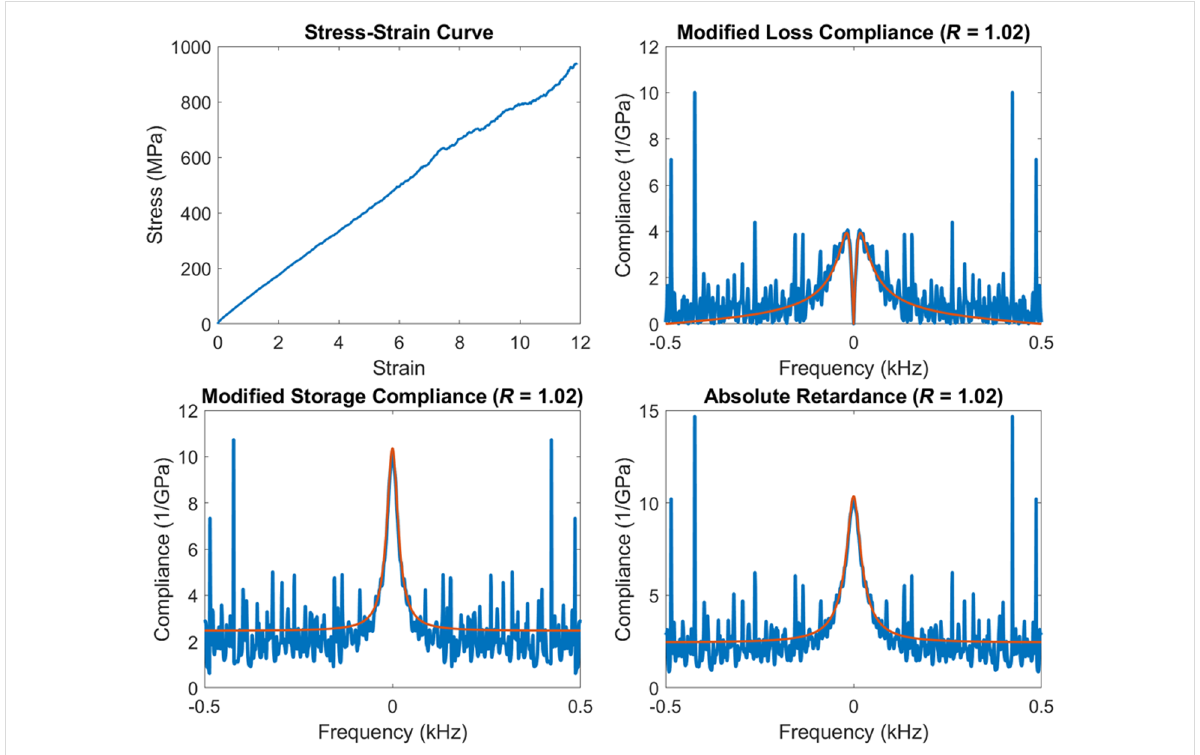
Figure 11: Illustration of the effect of noise in the experimental stress–strain curve on the calculated modified loss compliance, storage compliance and absolute retardance.